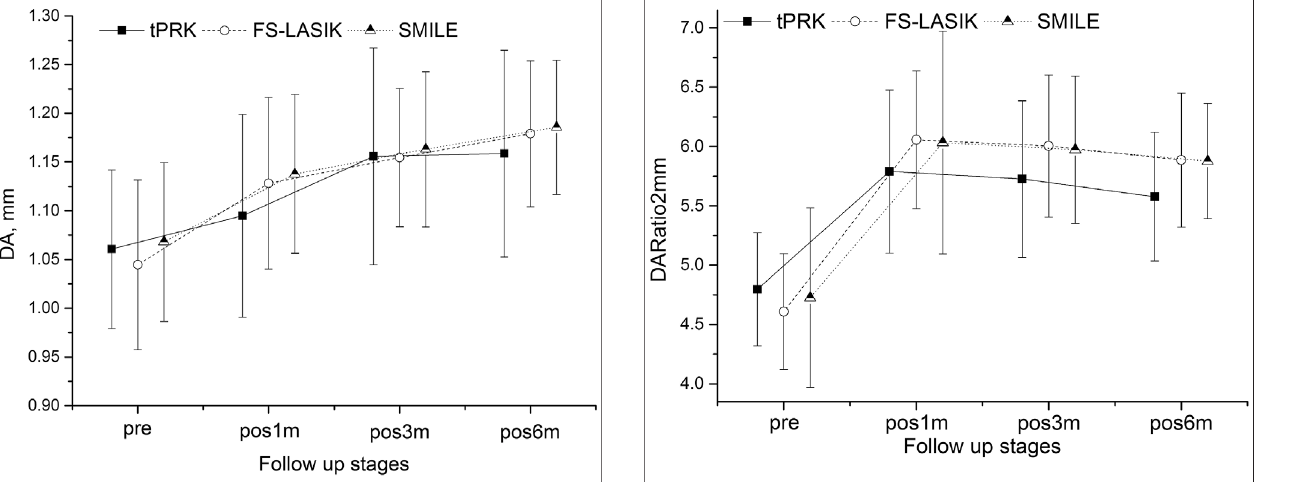
FIGURE 3 | Changes in the deformation amplitude (DA) throughout all follow-upstagesinthetPRK,FS-LASIK,andSMILEpatientgroups(meanand standard deviation).